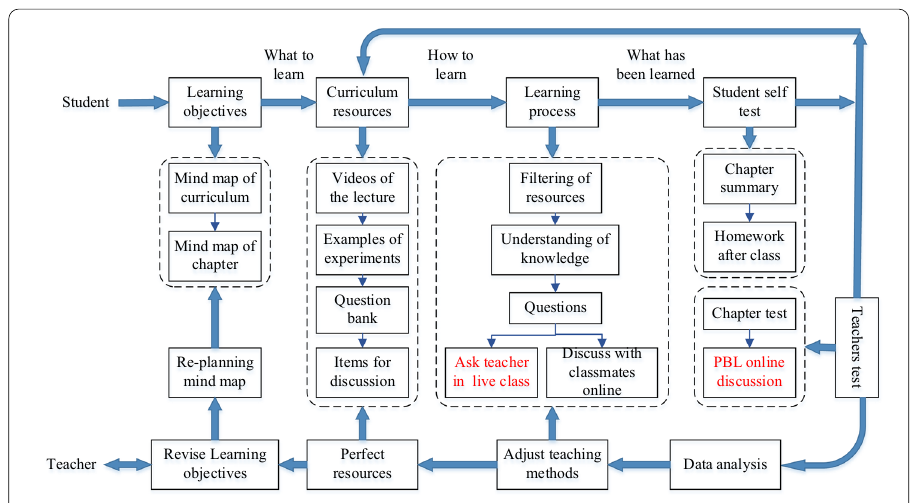
Fig. 1 Flow chart of hybrid closed-loop teaching